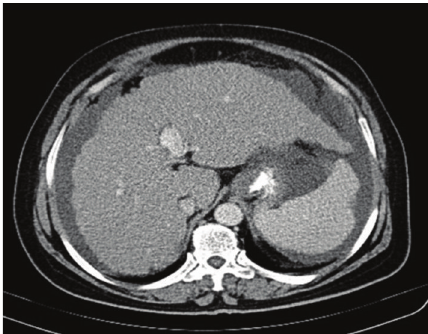
Figure 1: Abdominal CT scan showed a cirrhotic liver, spleno- megaly, and ascites.